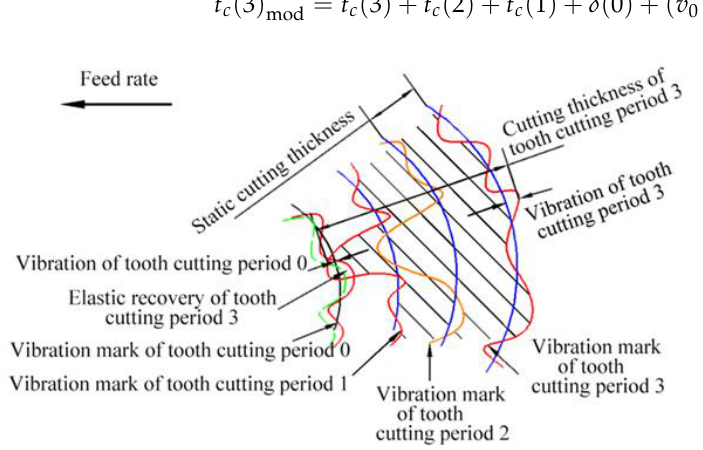
Figure 14. Instantaneous cutting thickness during micro-milling when tooth loses contact with the workpiece in tooth cutting periods 1 and 2.